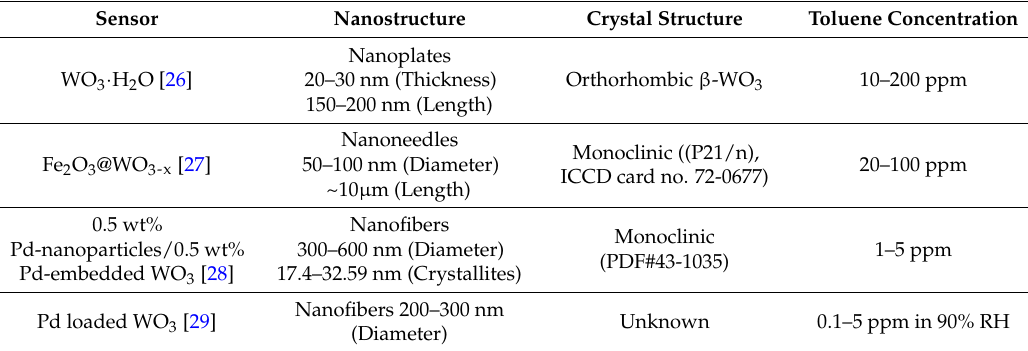
Table 7. A list of different samples used to detect